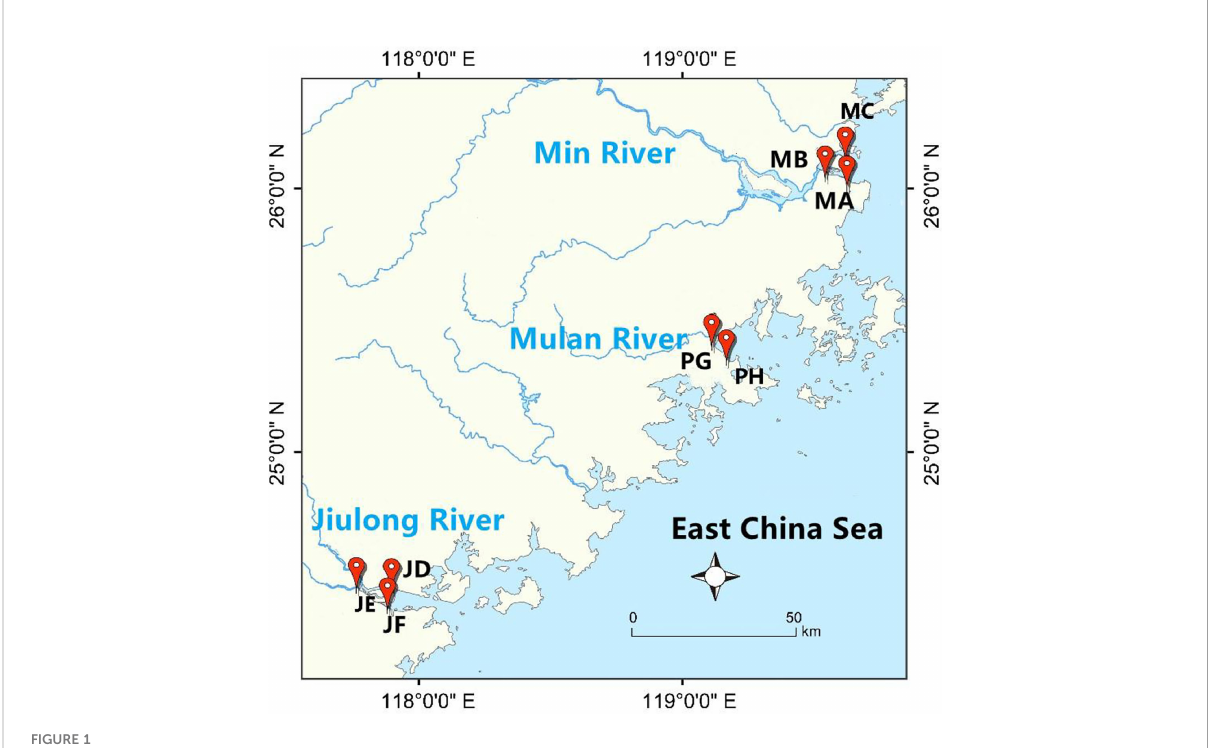
FIGURE 1 Study area and sampling